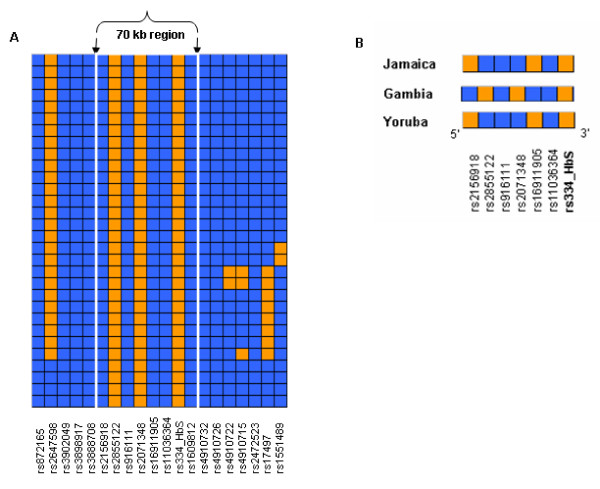
Pattern of HBB LD in Yoruba. The figure shows pairwise D' between the βS/βA allele (shaded allele) and 180 high frequency SNPs (minor allele frequency > 0.05). D' > 0.9 is shown in red, D' > 0.7 in green, D' > 0.5 in gray, and values < 0.5 in white. The figure also indicates the 70 kb region around β-globin, and the recombination hotspot (dark gray box).